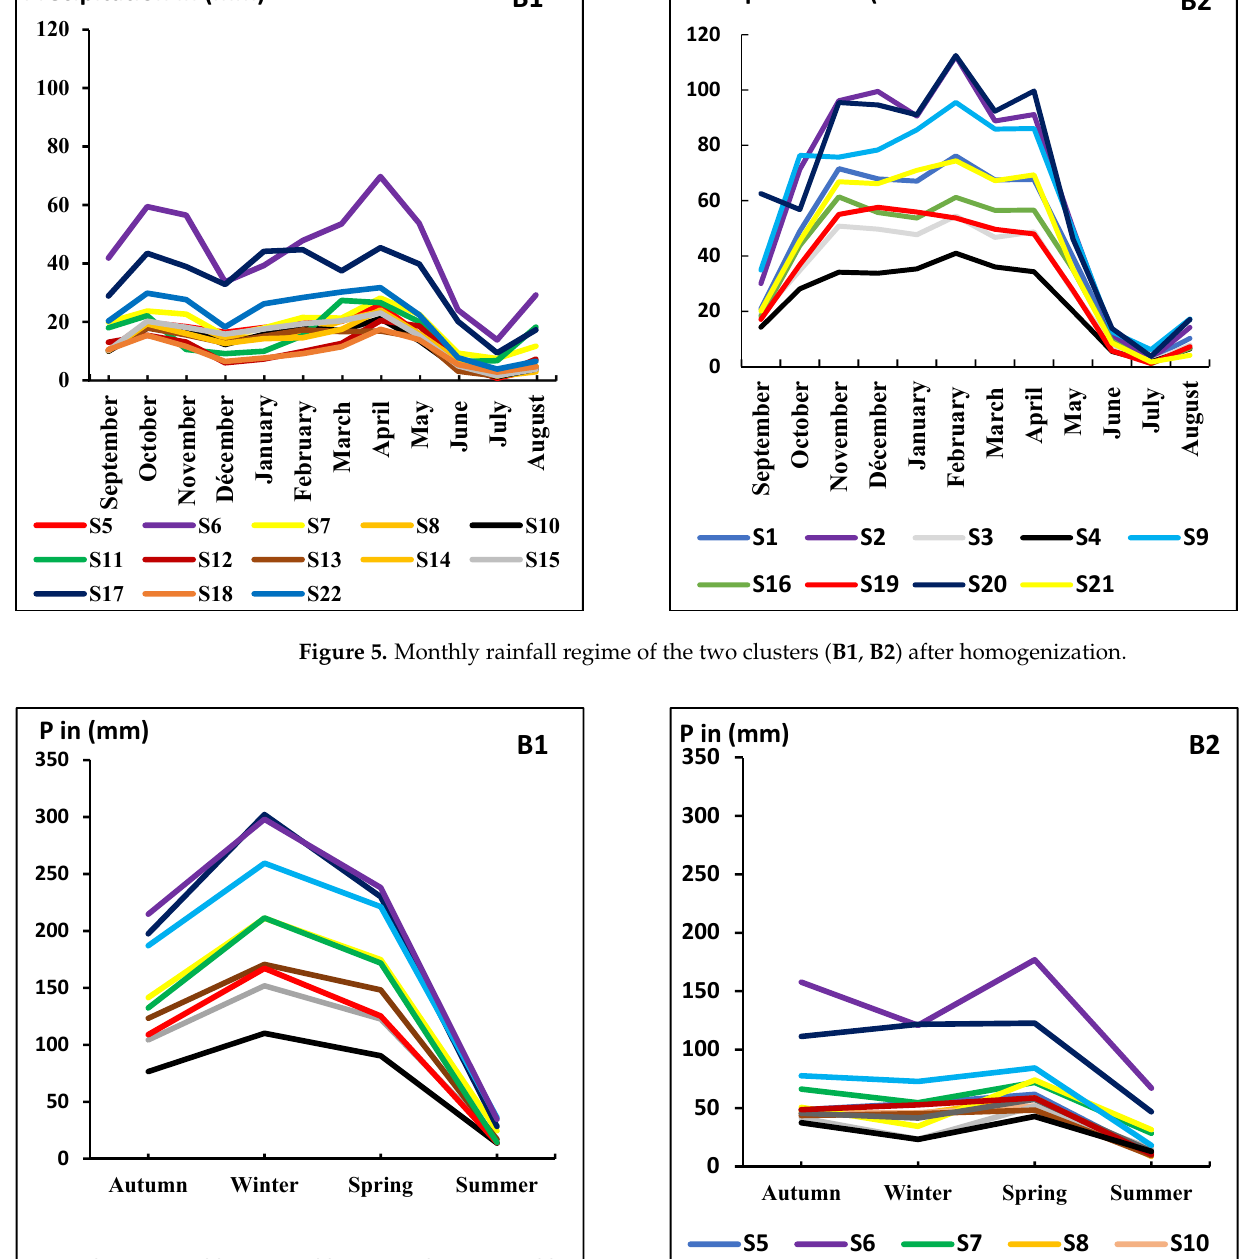
Figure 4. Clusters of stations ( A ) before and ( B ) after homogenization.